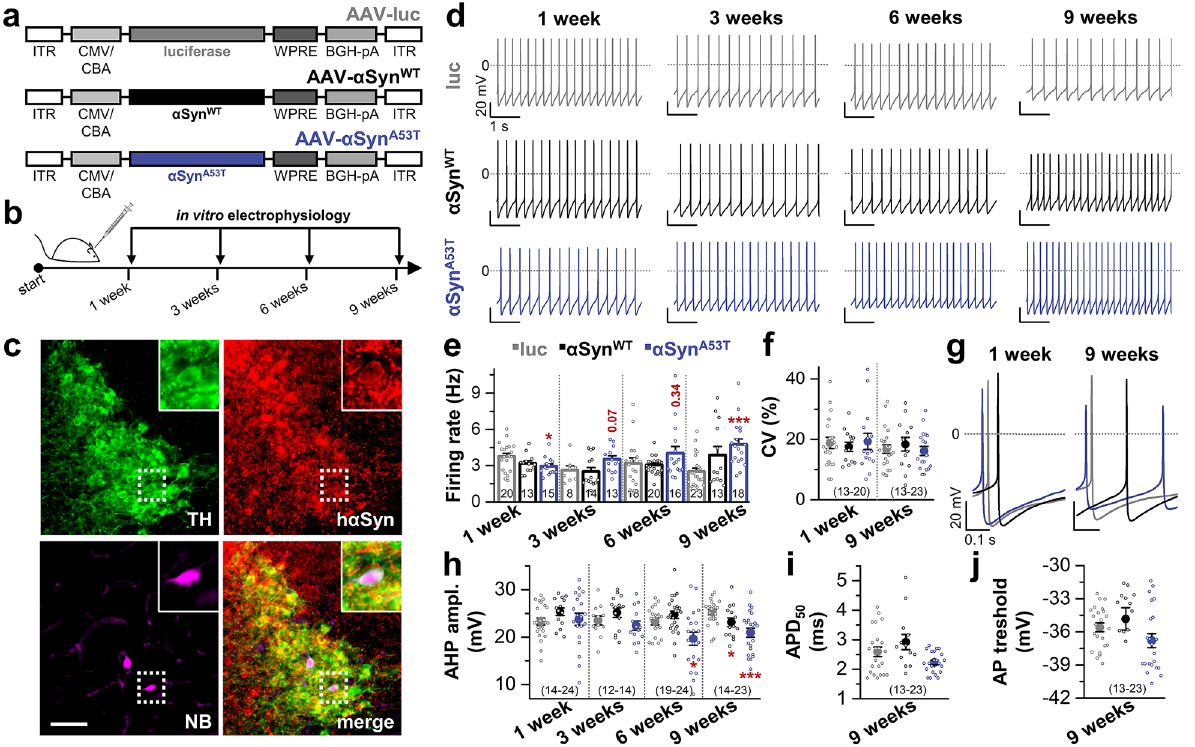
Figure 1. rAAV mediated αSyn A53T overexpression induces acceleration of the intrinsic pacemaker frequency in LC neurons. ( a ) rAAV1/2 vectors containing a chicken β-actin promoter hybridized with a CMV immediate early enhancer sequence (CMV/CBA) were injected into the right LC to drive expression of αSyn WT , αSyn A53T , or luc (control). WPRE, woodchuck hepatitis virus posttranscriptional regulatory element; BGH-pA, bovine growth hormone polyadenylation sequence; ITR, inverted terminal repeat. ( b ) Scheme illustrating the experimental design of the study. Mice were consecutively sacrificed 1, 3, 6 and 9 weeks after injection of rAAV vectors for in vitro electrophysiology. ( c ) Representative triple immunofluorescence staining for TH (green), human αSyn (red), or neurobiotin (NB, magenta). Co-localization identifies patched, NB-filled neurons as TH- and αSyn-positive. Scale bar: 100 µm. ( d ) Example recordings of spontaneously active luc, αSyn WT or αSyn A53T overexpressing LC neurons in the whole-cell current clamp configuration at 1, 3, 6 and 9 weeks after injection in the presence of synaptic blockers. ( e ) Quantification of the pacemaker frequency revealed a significant acceleration of action potential firing 9 weeks post-injection in αSyn A53T overexpressing animals compared to luc controls . ( f ) Analysis of the CV as a measure for regularity of the data shown in ( e ). ( g ) Representative AP of luc (grey), αSyn WT (black) and αSyn A53T (blue) overexpressing animals 1 and 9 weeks post-injection. The AP waveform of αSyn A53T overexpressing neurons showed time-dependent alterations. ( h – j ) Analyses of basic AP properties revealed a time-dependent reduction of the AHP amplitude in αSyn WT overexpressing mice at 9 weeks post-injection and in αSyn A53T overexpressing mice at 6 and 9 weeks post-injection ( h ), whereas APD 50 ( i ) and AP threshold ( j ) remained unchanged. Data are represented as mean ± SEM and also as individual data points. * p < 0.05; *** p < 0.001. [( e ) 1 week: unpaired Student’s t -test vs. luc; 3 weeks: αSyn WT , Mann–Whitney-U test vs. luc/αSyn A53T , unpaired Student’s t -test vs. luc; 6 weeks: Mann–Whitney-U test vs. luc; 9 weeks: αSyn WT , Mood’s median test vs. luc/αSyn A53T , Mann–Whitney-U test vs. luc. ( f ) unpaired Student’s t -test vs. corresponding luc. ( h ) 1 week and 3 weeks: unpaired Student’s t -test vs. corresponding luc; 6 and 9 weeks: αSyn WT , unpaired Student’s t -test vs. corresponding luc/αSyn A53T , Welch’s t -test vs. corresponding luc. ( i , j ) Mann–Whitney-U test vs. corresponding